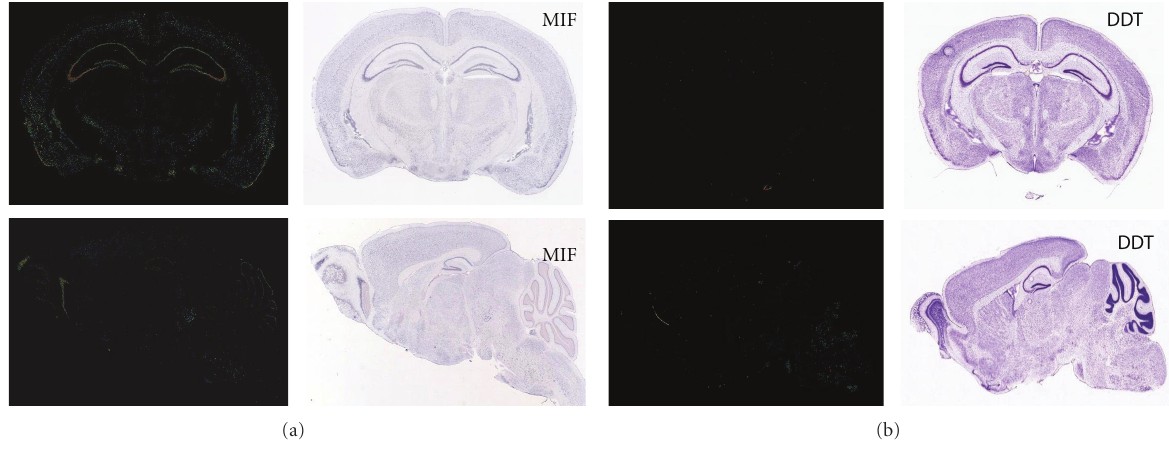
Figure 3: MIF and DDT distribution in the brain. Representative in situ hybridization images of MIF mRNA (a) and DDT mRNA distribution (b) in adult mouse brain (left) with consecutive counterstained brain section (Nissl stain, right). Upper panels of (a) and (b) represent coronal plane; lower panels show sagittal plane. Data were provided from the Allan Brain Atlas website (http://www.brain- map.org/), and the Brain Explorer 1.3 software was utilized for the visualization of gene expression